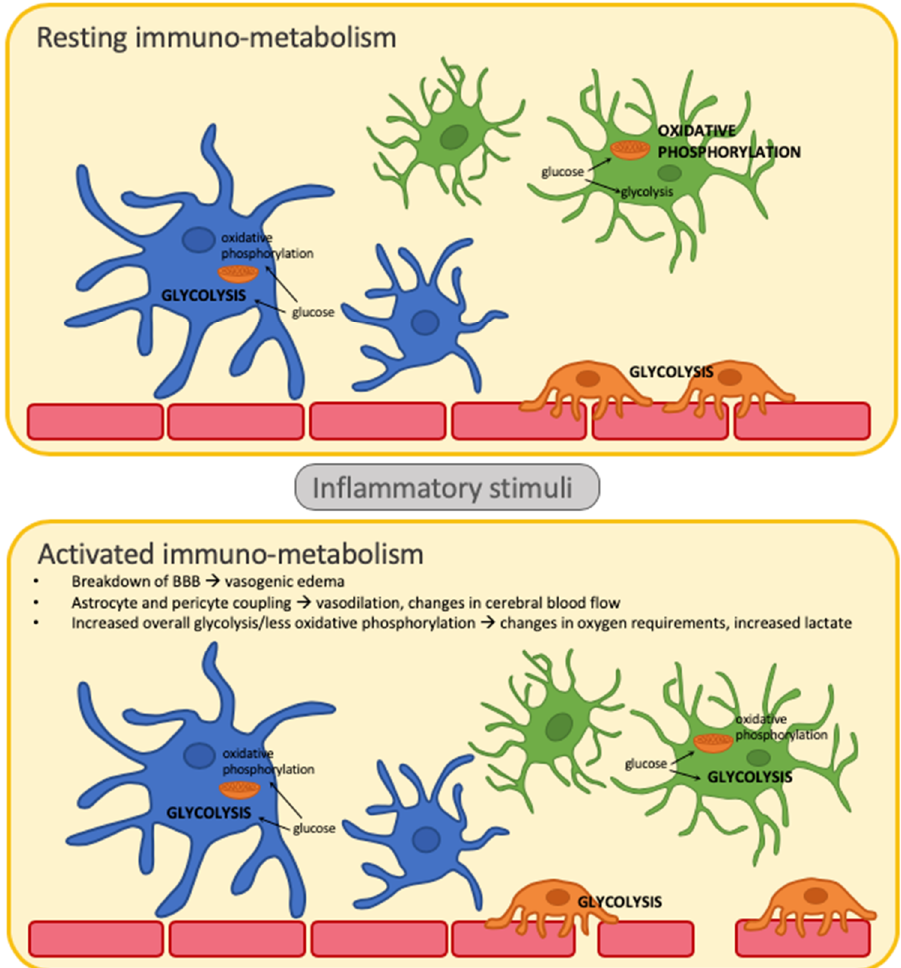
Figure 1. Immunometabolism of CNS immune cells at rest and in response to inflammatory stimuli. Blue cells are astrocytes, green cells are microglia, orange cells are pericytes, and red cells are the endothelial cells lining vasculature. Bolded and capitalized letters indicate the primary mode of cellular metabolism during either the resting or activated state. Astrocytes rely on glycolysis during rest and continue to use this as their primary mode of metabolism when activated by an inflammatory trigger, however in an upregulated manner. Pericytes also use glycolysis for energy production during both resting and activated states. Microglia metabolize using oxidative phosphorylation during rest, and switch to glycolysis during activated states.